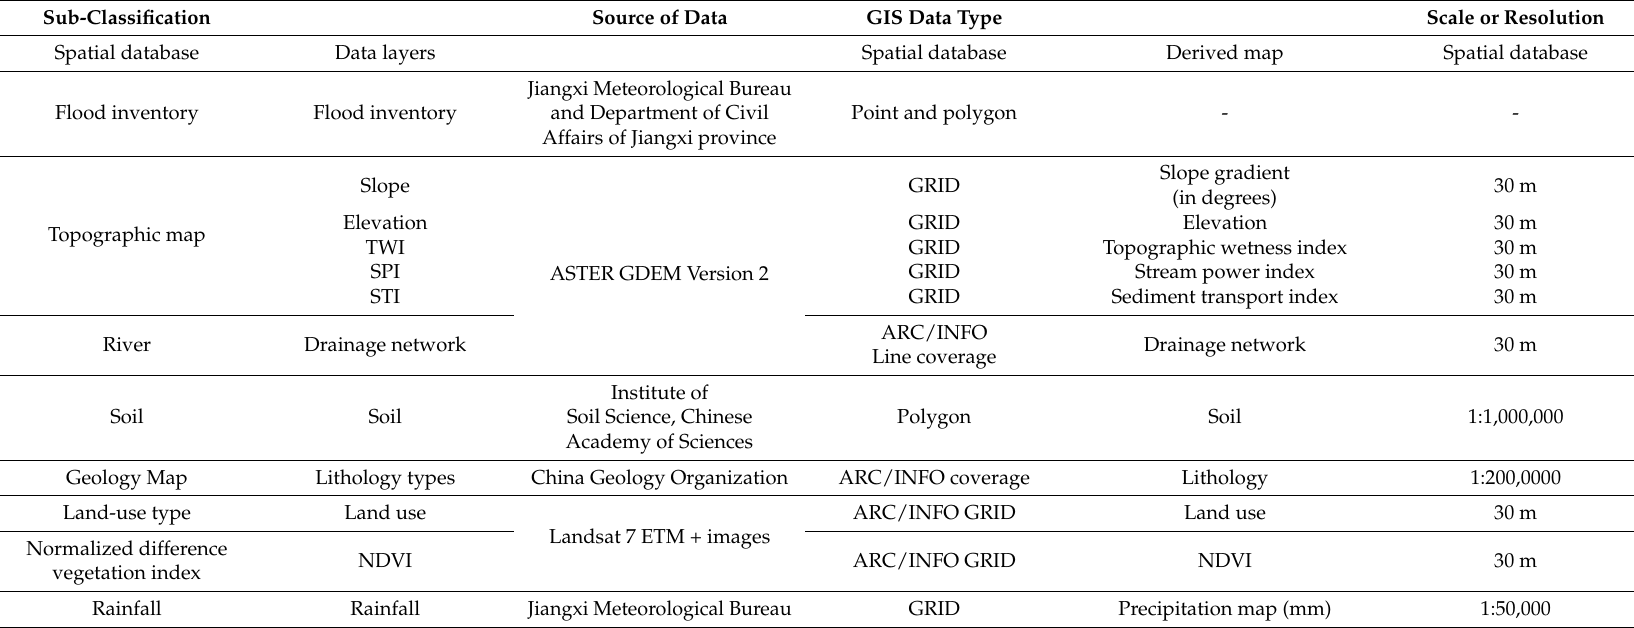
Table 1. Available data used in the susceptibility assessment, including the data sources and associated factor classes for FSM in the study